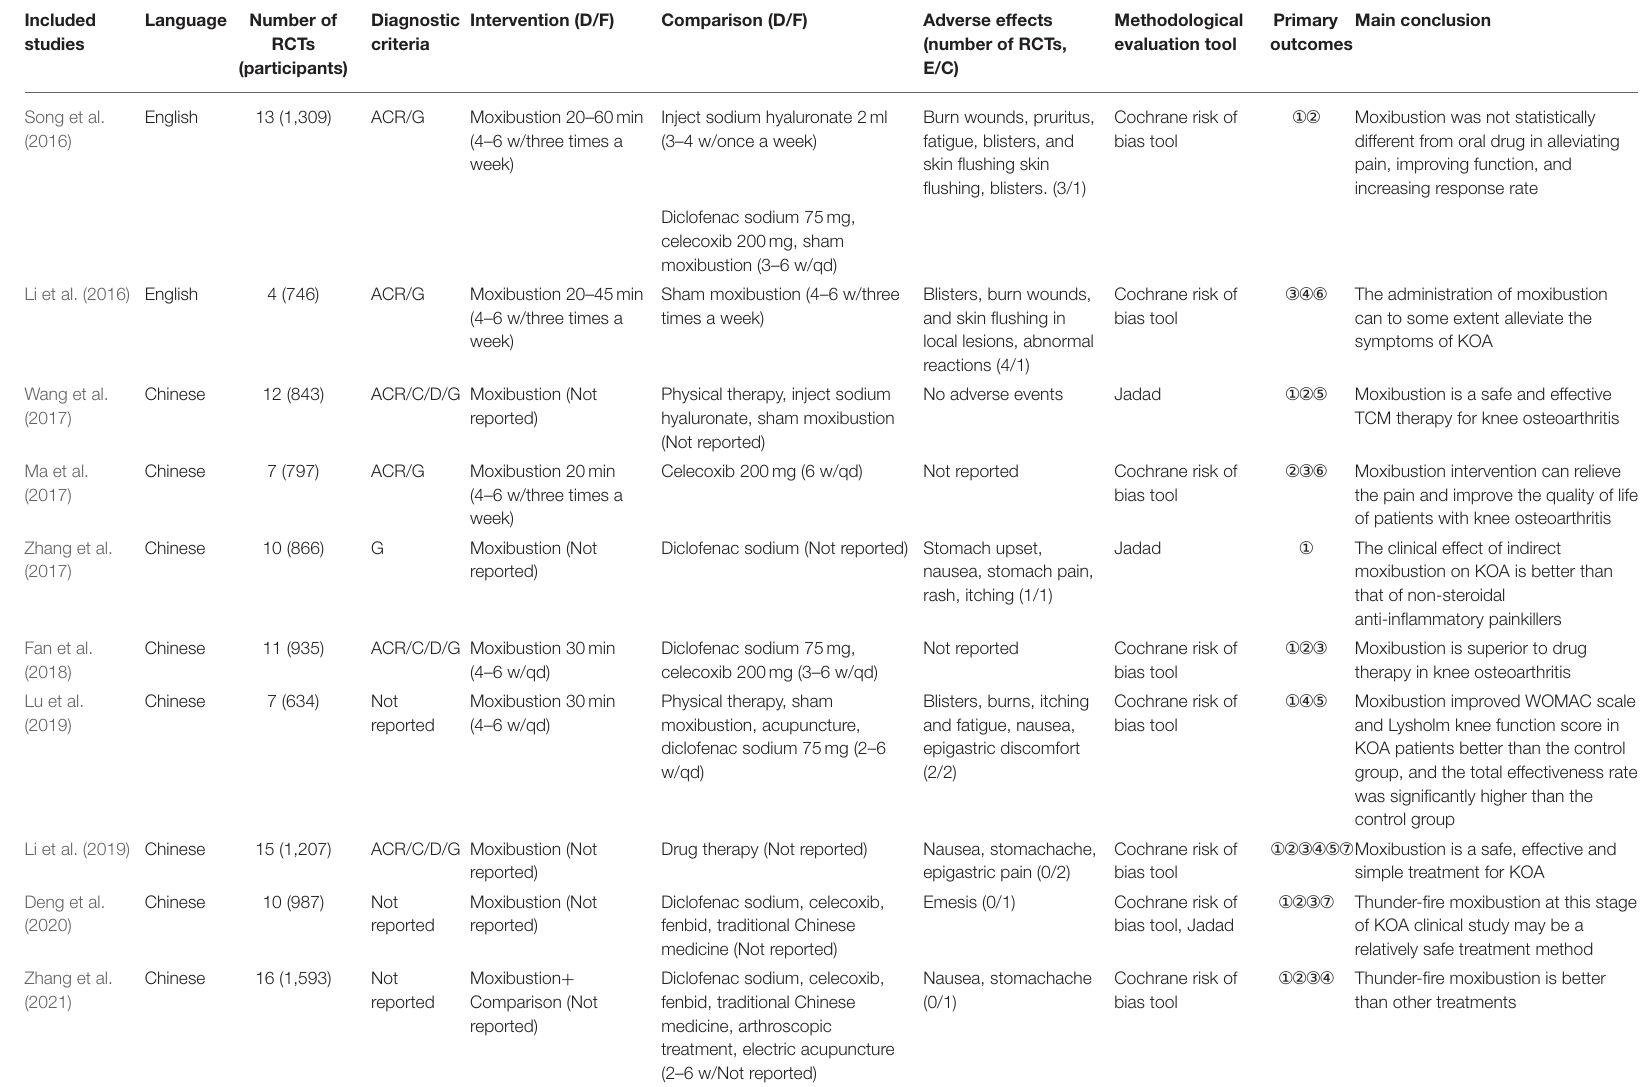
TABLE 1 | Characteristics of the included